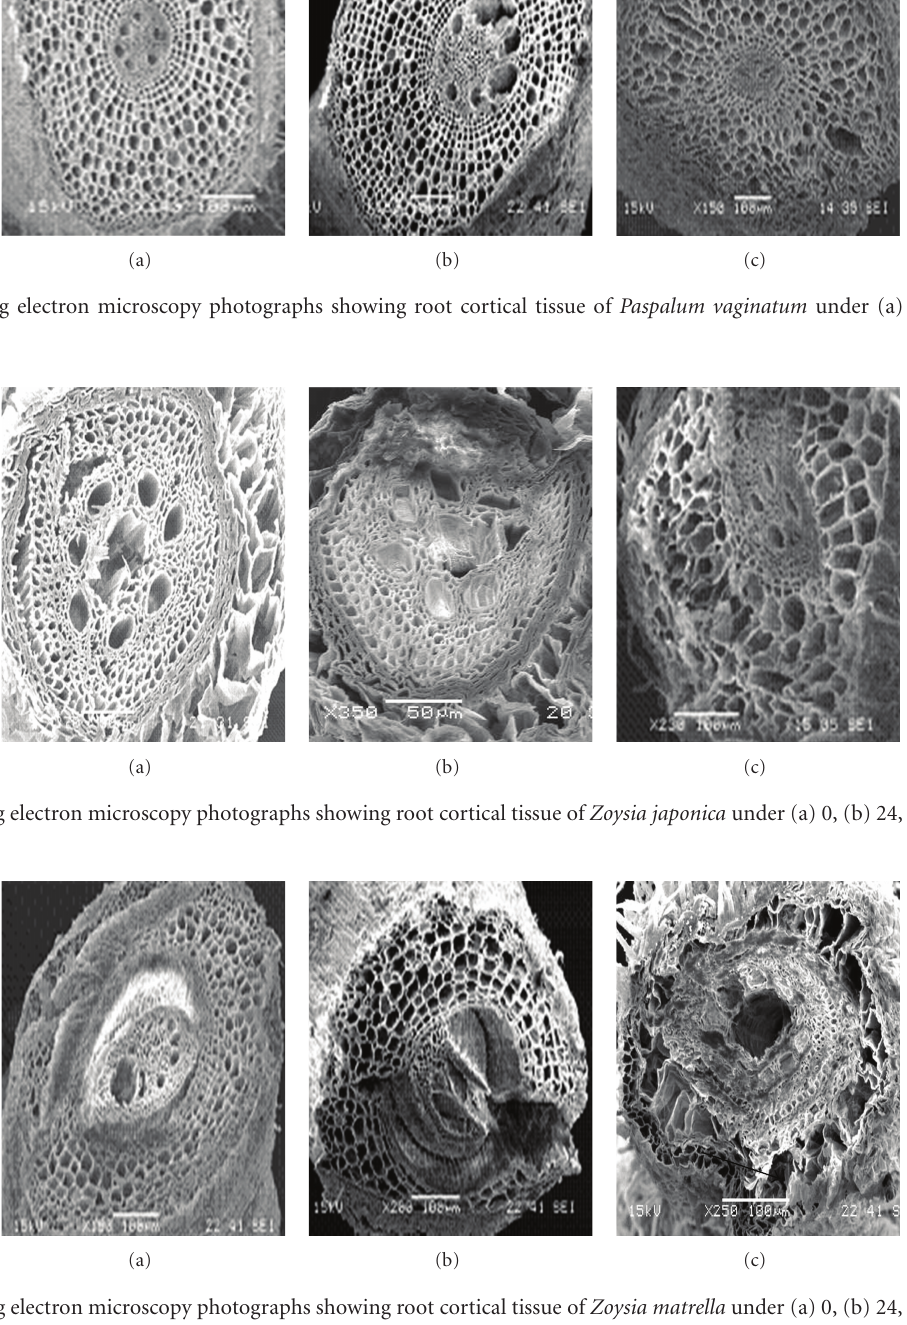
performance under salinity-stressed conditions [13,